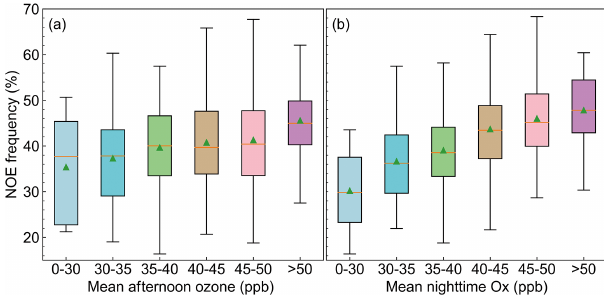
Figure 5. The relationship of NOE frequencies with afternoon ozone (a) and with nighttime O x (b) at 814 Chinese sites. The col- ored box-and-whisker plots (showing the 5th, 25th, 50th, 75th, and 95th percentiles as well as the mean values, which are denoted as triangles) present the NOE frequencies at different